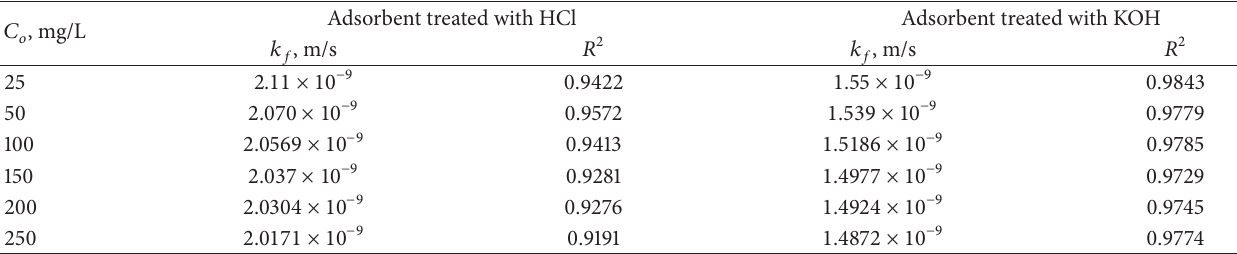
Table 2: Mass transfer coefficients from the external diffusion model for the adsorption of phenol.